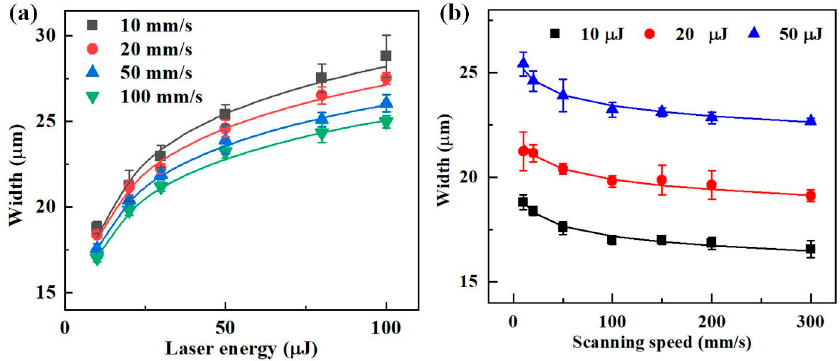
Figure 5. Effects of parameters on width. ( a ) The width varies with laser energy. ( b ) The width varies with scanning speed.